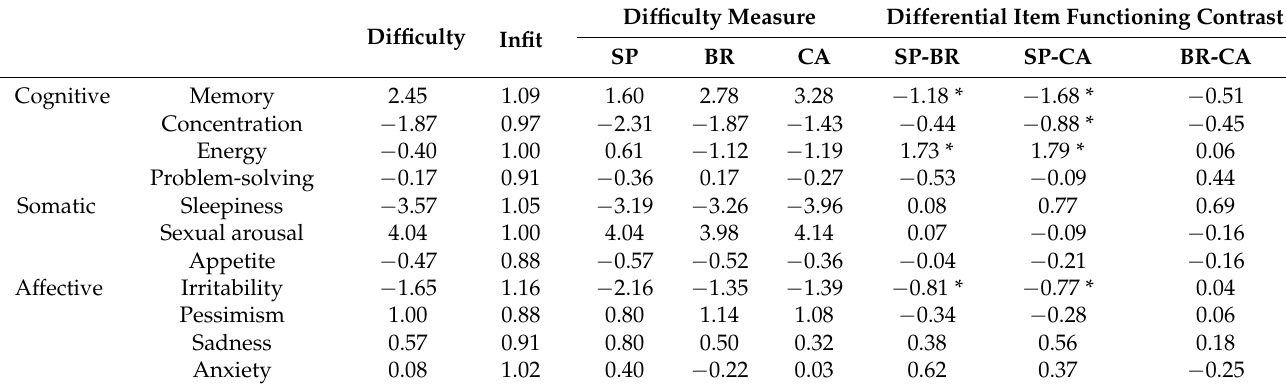
Table 3. Item difficulty, fit measures, and differential item functioning of subscales (MRhI—11 items).